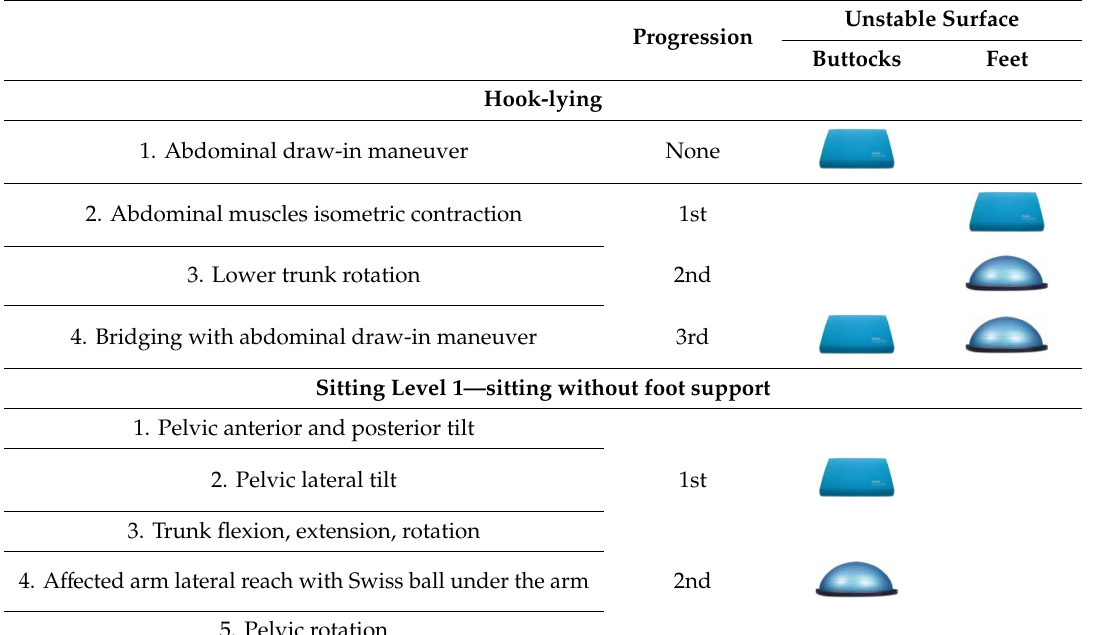
Table 1. Trunk exercises for the experimental